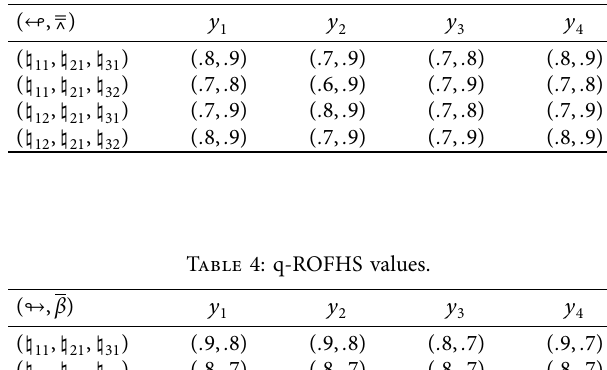
Table 3: q-ROFHS values.